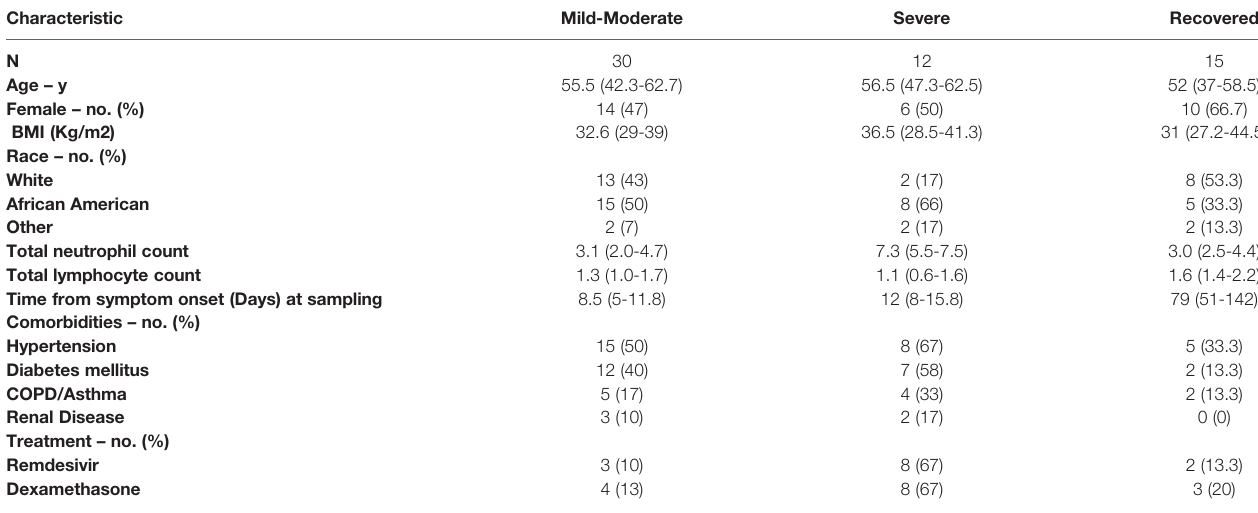
TABLE 1 | Patient characteristics by disease